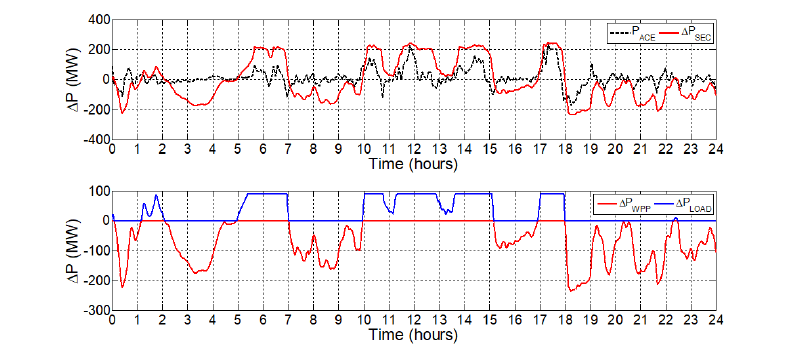
Figure 12. Secondary response from AGC.